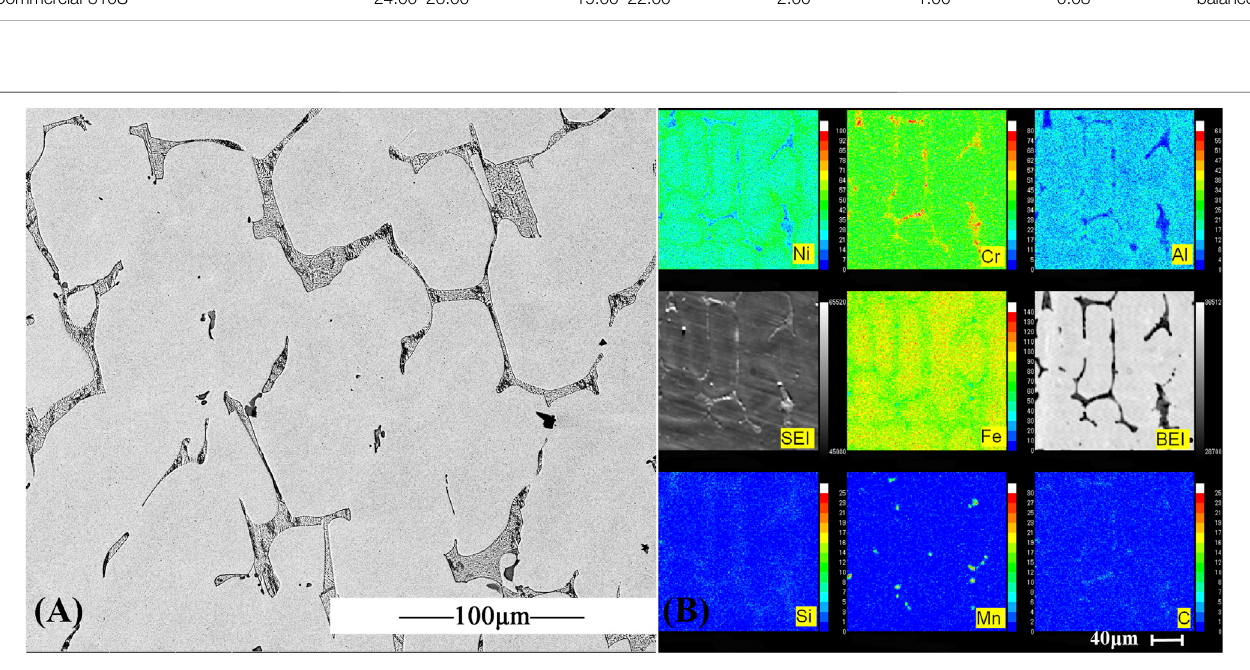
Frontiers in Materials |